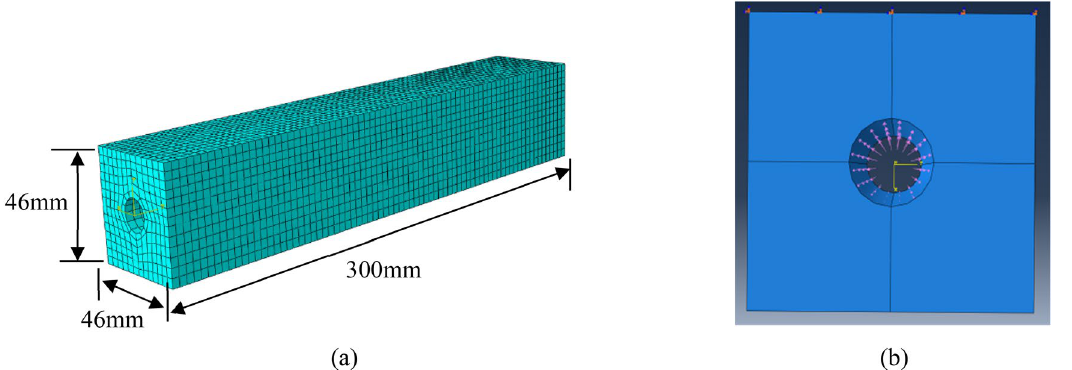
Figure 4. Model setting up. ( a ) Simulation object with meshing. ( b ) Rust expansion force